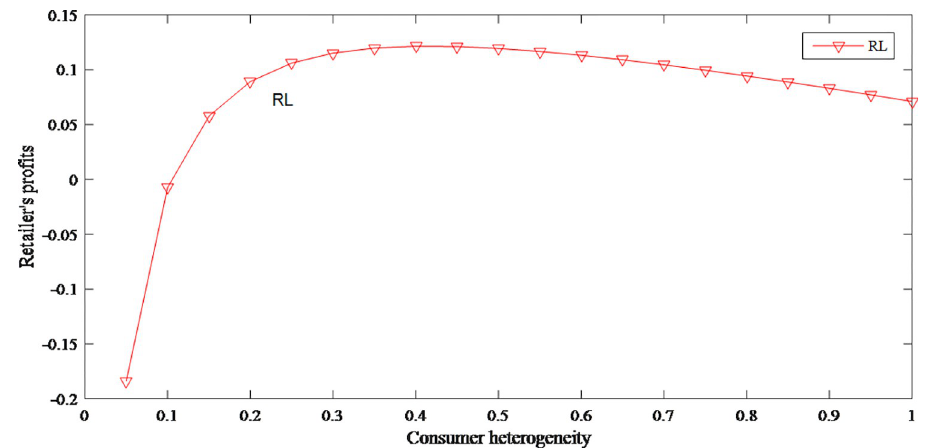
Fig 18. The impact of consumer heterogeneity on retailer’s profits.